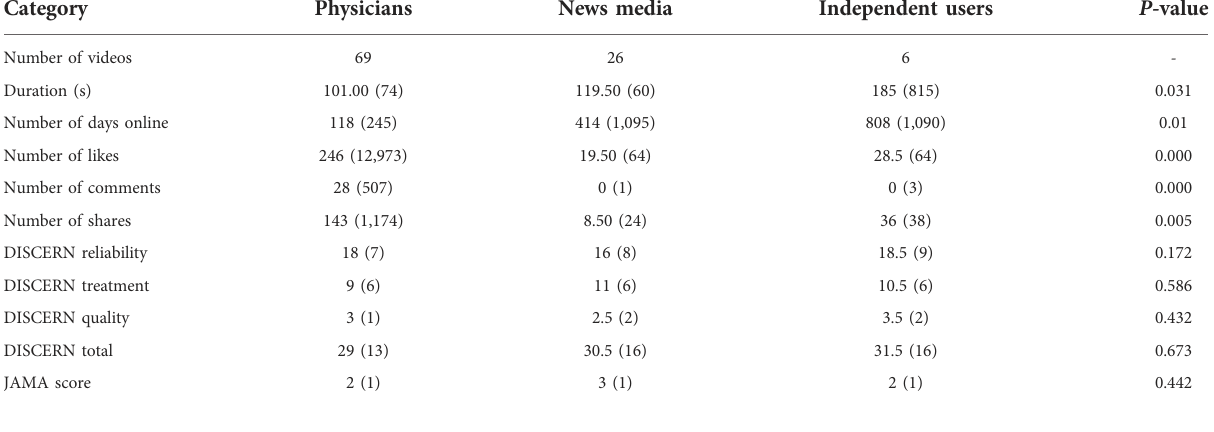
TABLE 2 General characteristics and scores of the understudied videos from different sources.